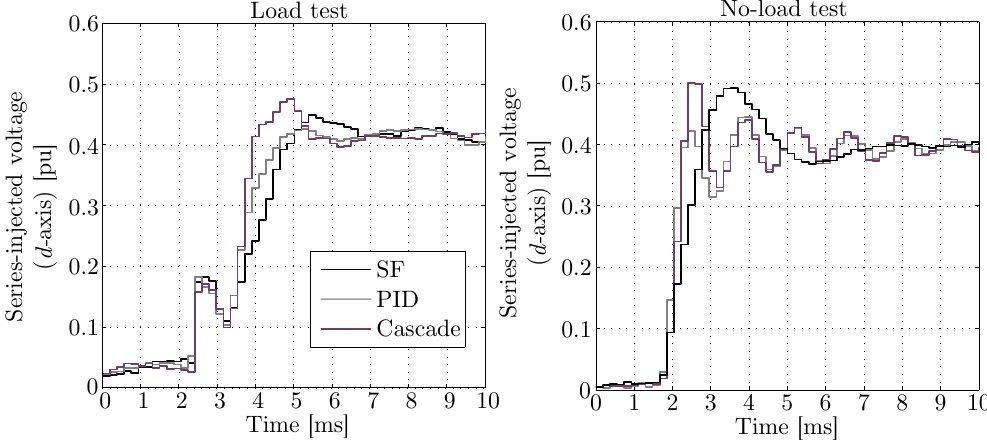
Figure 22. Experimental results. d -axis component of the series-injected voltage for the PID, the cascade, and the SF controllers ( left ) with the load and ( right ) without the load.